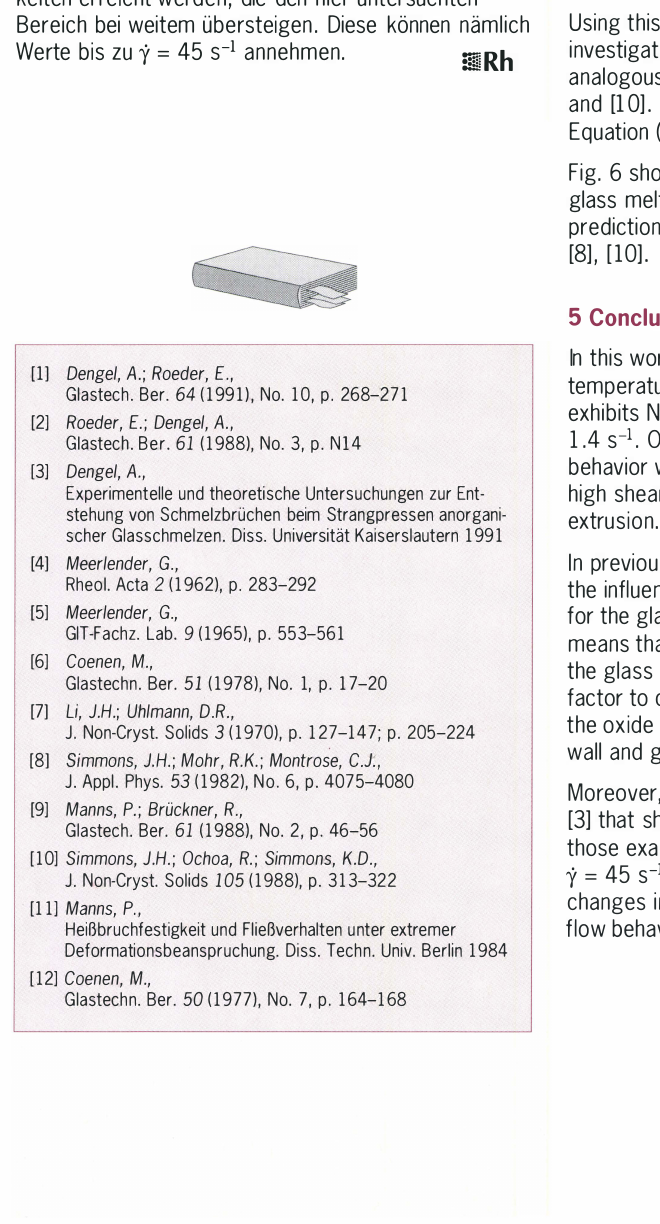
Abb. 6: Verlauf der normierten Viskositiit iiber der normierten Verformungs­ geschwindigkeit Fig. 6: Normalized viscosity as a function of the calculated extension